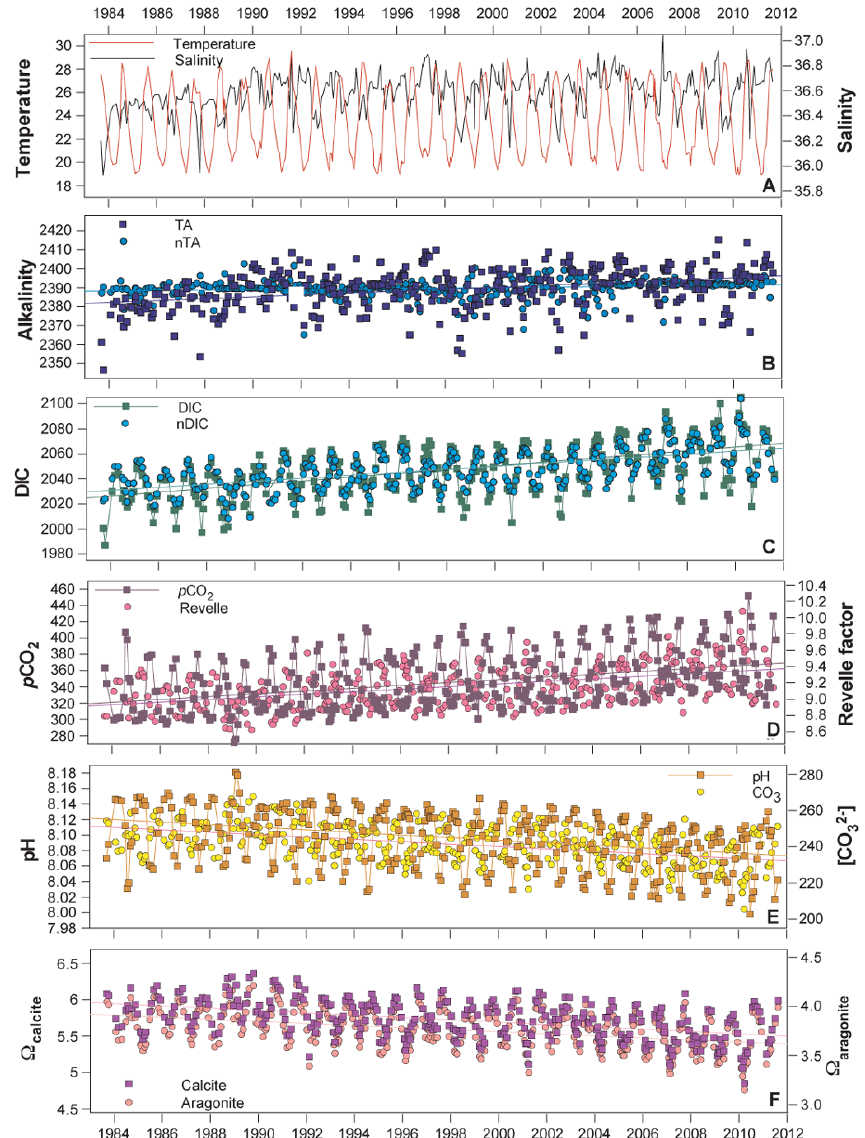
Fig. 5. Long-term observations and trends of surface hydrography, seawater carbonate chemistry and ocean acidification indicators from 1983 to 2011 at the BATS (Bermuda Atlantic Time-series Study; 31 ◦ 40 0 N, 64 ◦ 10 0 W) and Hydrostation S (32 ◦ 10 0 N, 64 ◦ 30 0 W) sites located near Bermuda in the NW Atlantic Ocean. Slopes and statistics of regressions are listed in Table 1. (A) Sea surface temperature ( ◦ C; black line) and salinity (red line). (B) Surface total alkalinity (TA,µmolkg − 1 , blue symbol) and salinity normalised TA (nTA;µmolkg − 1 , cyan symbol). (C) Surface dissolved inorganic carbon (DIC, µmolkg − 1 , green symbol) and salinity normalised DIC (nDIC; µmolkg − 1 , cyan symbol). (D) Seawater p CO 2 (µatm; purple symbol) and Revelle factor ( β) (salmon symbol). (E) Surface seawater pH (orange symbol) and [CO 2 − (µmolkg − 1 , yellow symbol) (F) Surface saturation state of calcite ( (cid:127) calcite ) (purple symbol) and aragonite ( (cid:127) calcite ) (light pink